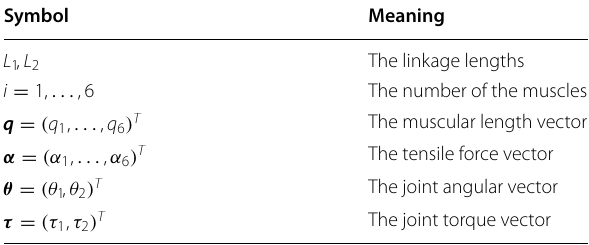
Table 1 Symbol list of the musculoskeletal structural parameter in the Section: System static relations Symbol Meaning The linkage lengths The number of the